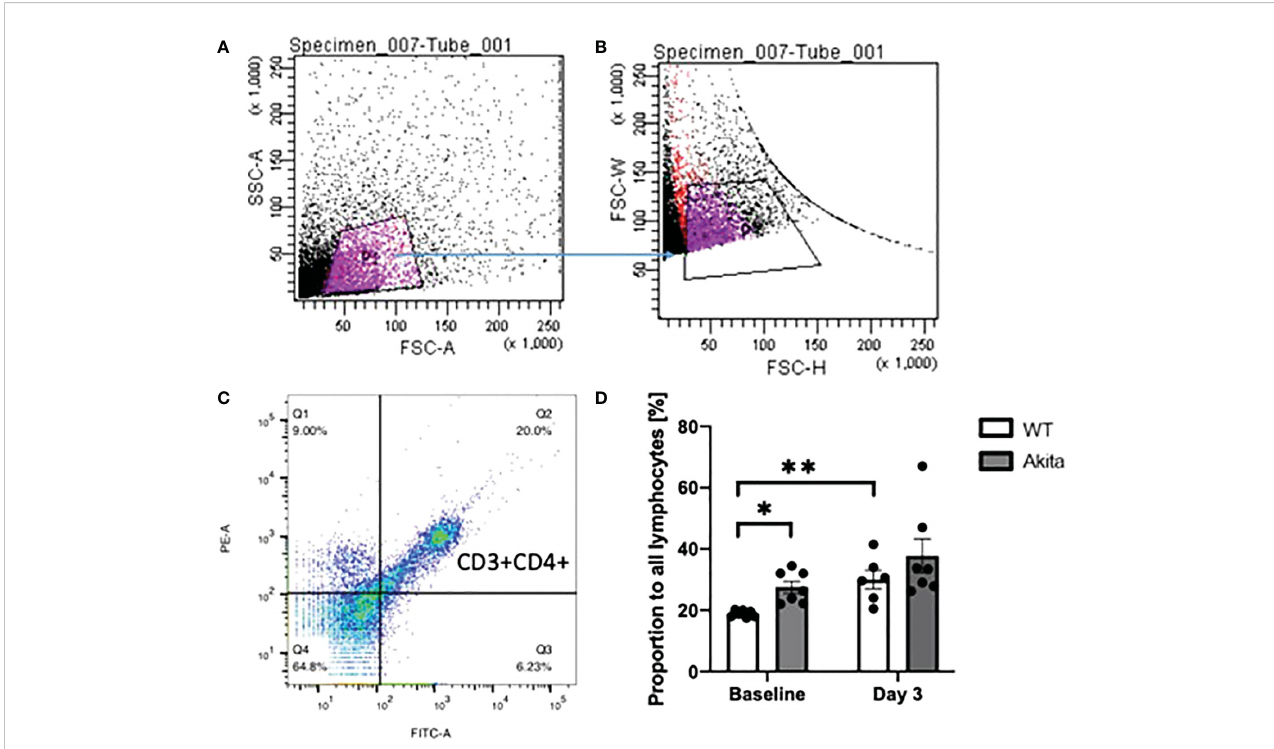
FIGURE 8 Proportion of CD3+CD4+ T cells in lymphocytes in peripheral blood samples of WT mice and Akita mice at baseline and at day 3 after corneal alkaline injury (A) Gating of lymphocytes (P1). (B) Gating of single cells against double or multiple cells (P2). (C) Gating of CD3+CD4+ T cells. (D) Akita mice had a higher abundance of CD3+CD4+ T cells in peripheral blood as compared to WT mice at baseline as indicated by an unpaired t -test ( n = 7, p = 0.0146). WT mice had a signi fi cant increase of CD3+CD4+ cells in the peripheral blood at day 3 after the injury as indicated by a paired t -test ( n = 7 for both the WT and Akita groups, p = 0.0022). *p<0.05;